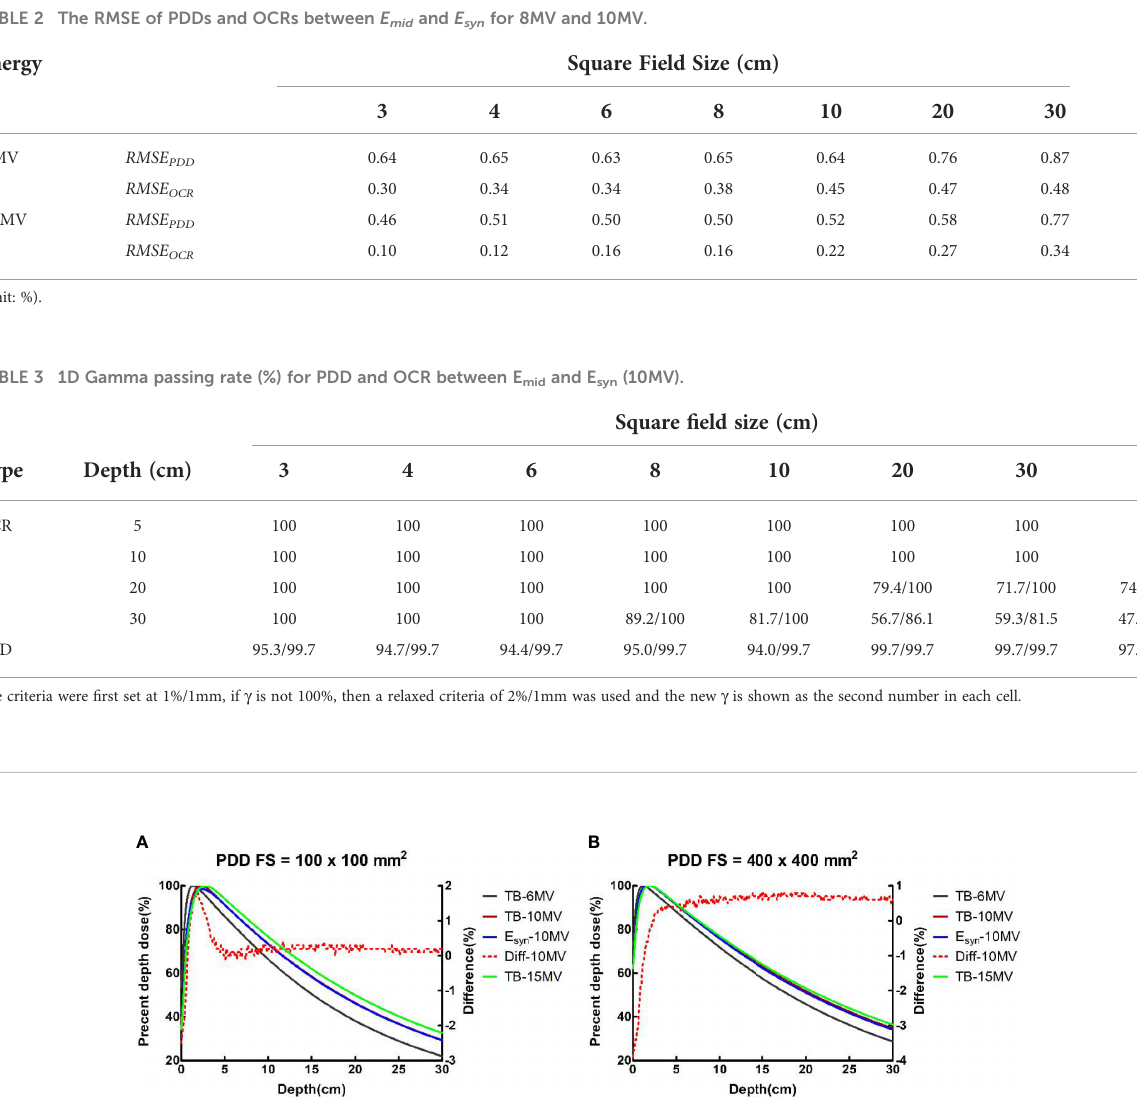
TABLE 2 The RMSE of PDDs and OCRs between E mid and E syn for 8MV and 10MV. Energy Square Field Size (cm)